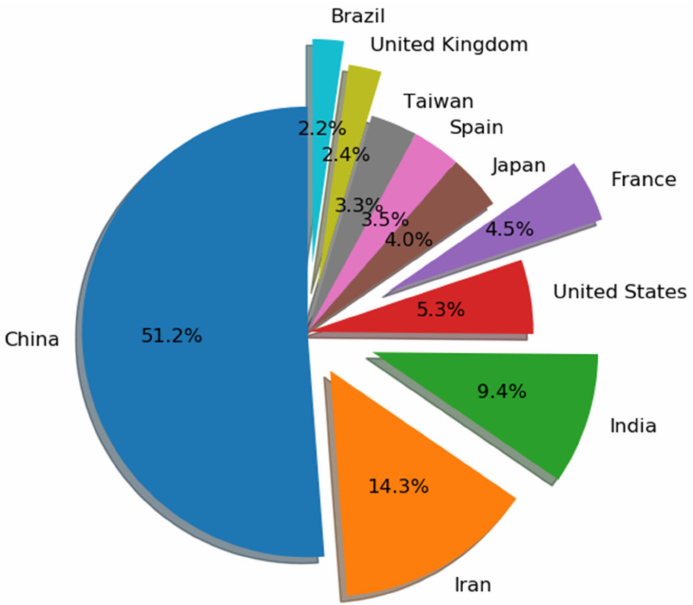
Figure 16. Research output of top 10 most productive countries across the